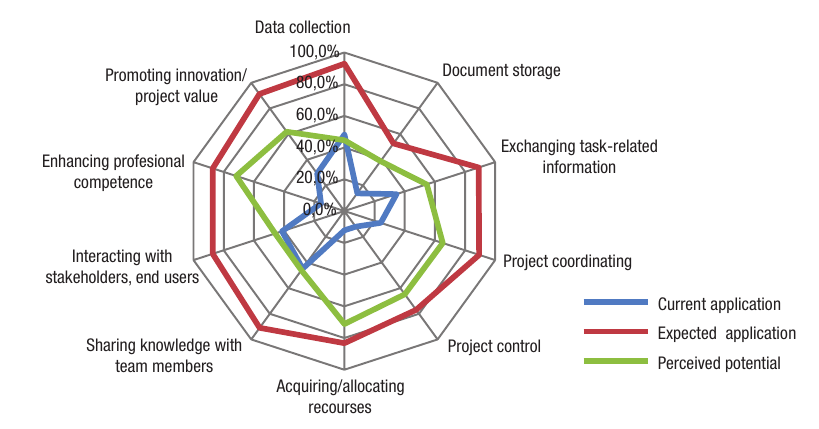
Fig. 9. Potential application of social media in temporary